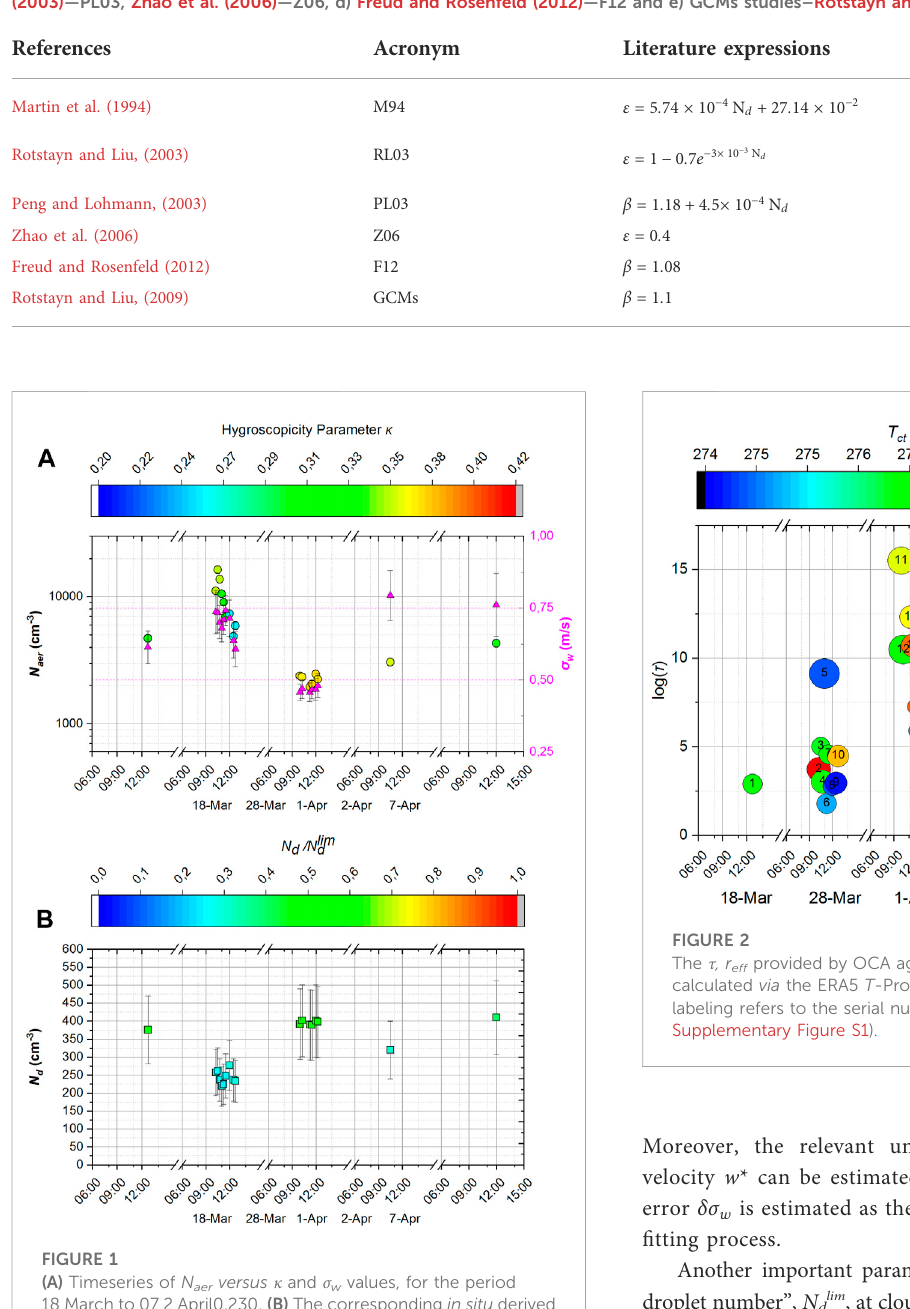
FIGURE 1 (A) Timeseries of N aer versus κ and σ w values, for the period 18 March to 07 2 April0,230. (B) The corresponding in situ derived N d values colored by the ratio N d / N d lim as derived by the